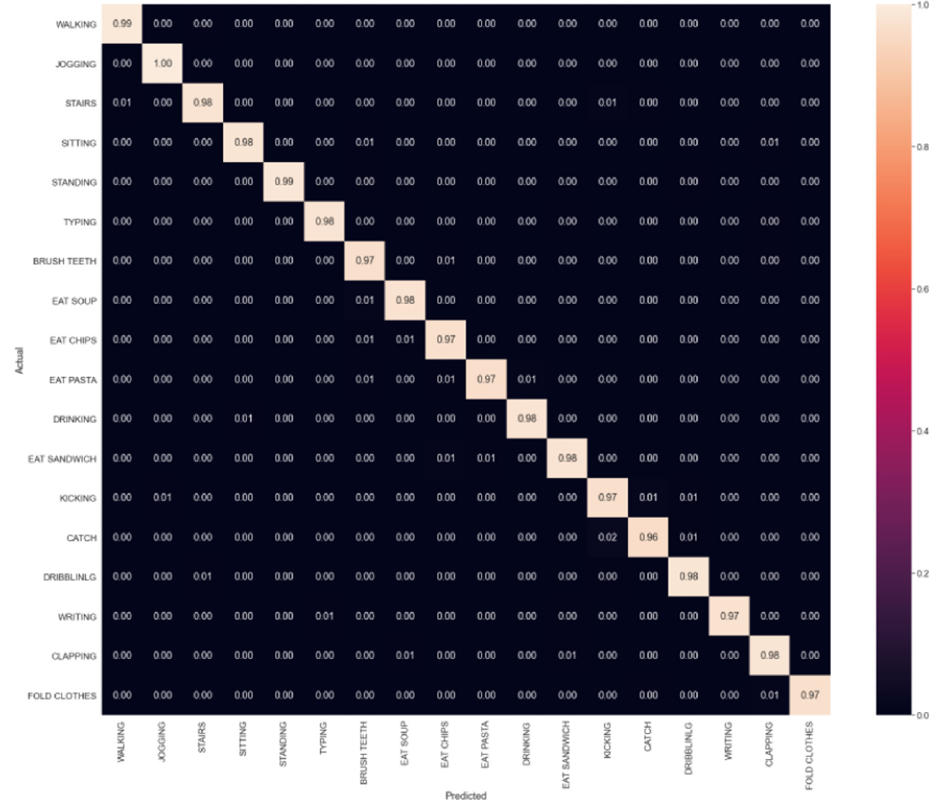
Figure 7. The confusion matrix of the classification of eighteen activities for the ELM algorithm. Table 6. The performances of SLFN with the ELM algorithm for 18 types of physical activities.